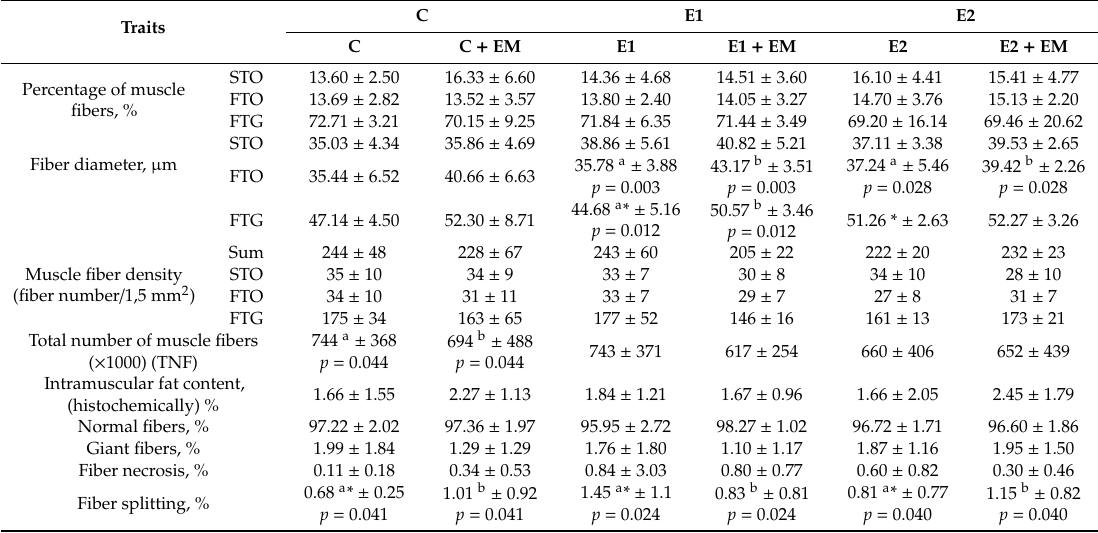
Table 4. E ff ects of e ff ective microorganisms (EM) on the microstructure of longissimus lumborum muscle in pigs fed on diets with proteins of di ff erent